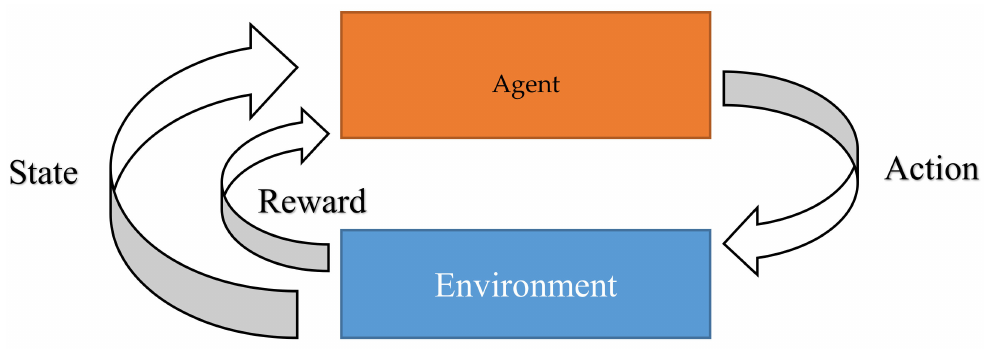
Figure 3. The DQN technique elements.